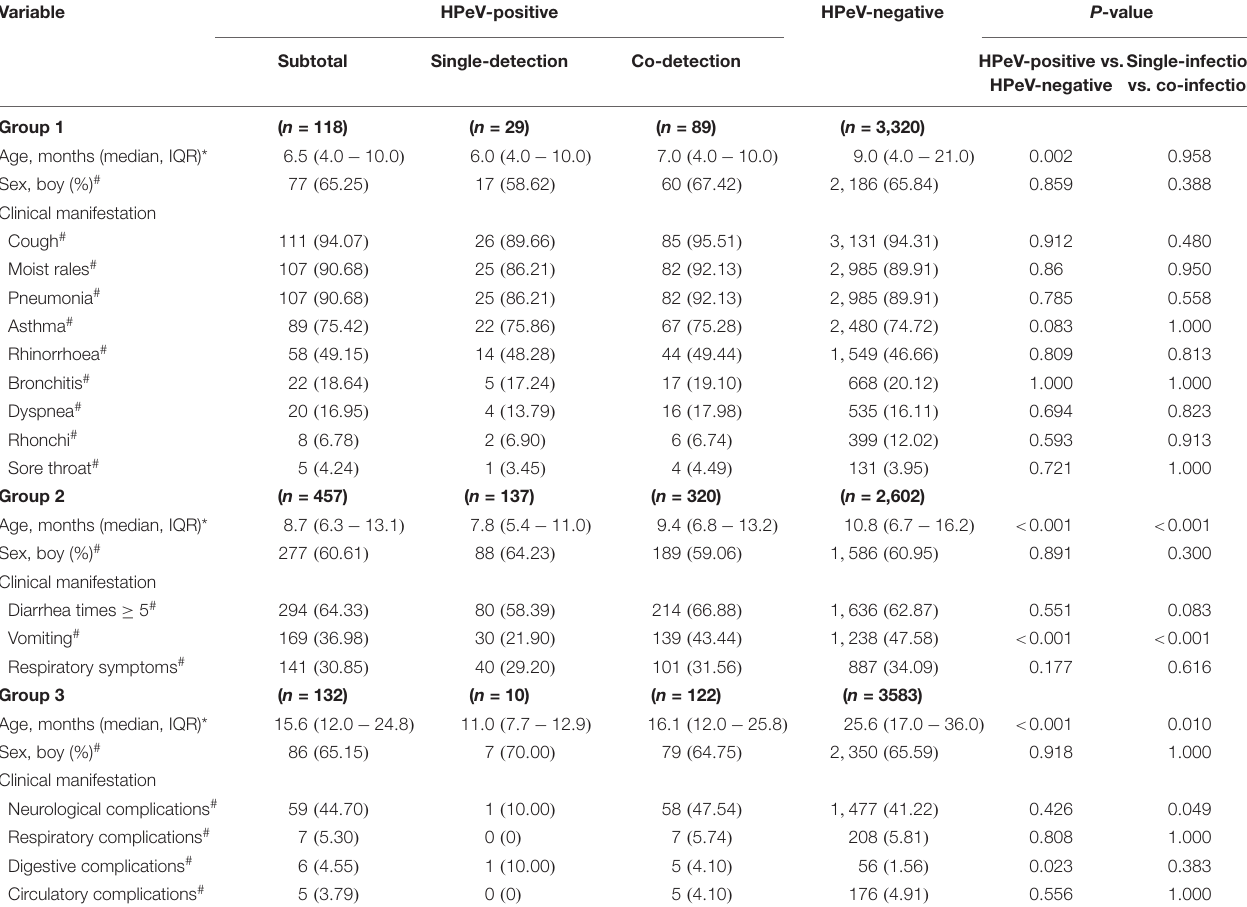
TABLE 2 | The demographic and clinical characteristics of the HPeV infected patients compared with non-infected. Variable HPeV - positive HPeV-negative P -value Subtotal Single-detection Co-detection HPeV-positive vs.